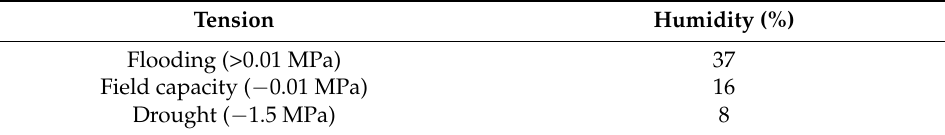
Table 1. Water retention tension.